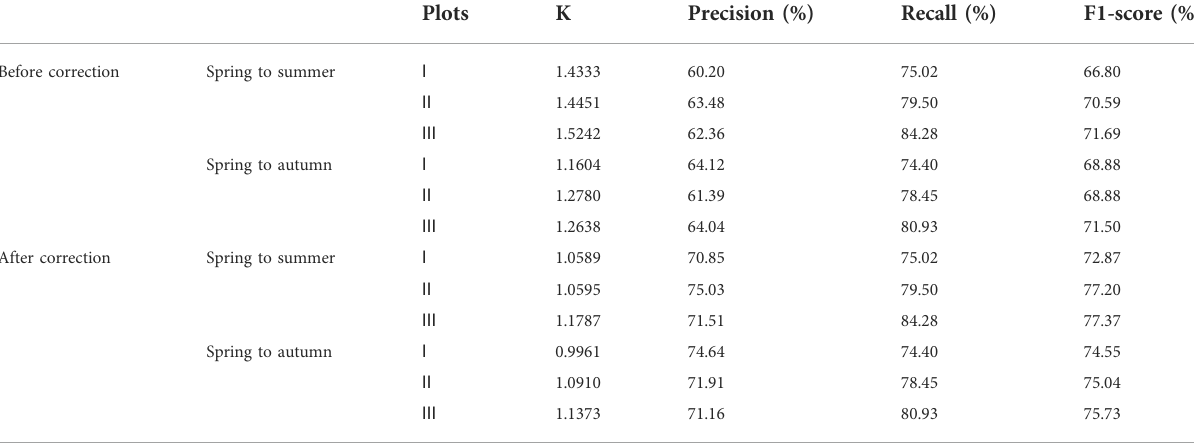
TABLE 4 Early warning assessment of S. alterni fl ora diffusion. Plots K Precision (%) Recall (%) F1-score (%) Before